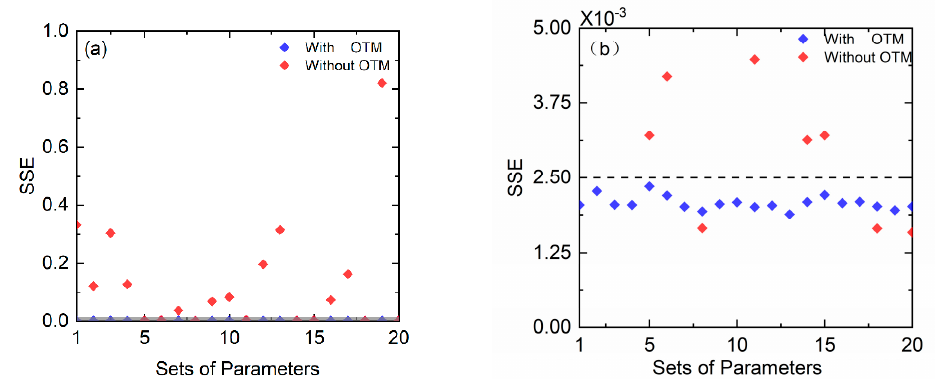
Figure 4. ( a ) The values of SSE between the simulated and measured WMS– 2f/1f spectral profile. The red diamond indicates the minimal SSE of the fitting by the optimized initial parameters obtained from the orthogonal test method, while the red ones represent the minimal SSE of the fitting by random initial parameters. ( b ) presents the zoomed in view of the gray region in ( a ). It is evident that all the SSE from the optimized initial parameters are less than 0.0025, while it is only 3 sets for random initial parameters, as shown in ( b ).